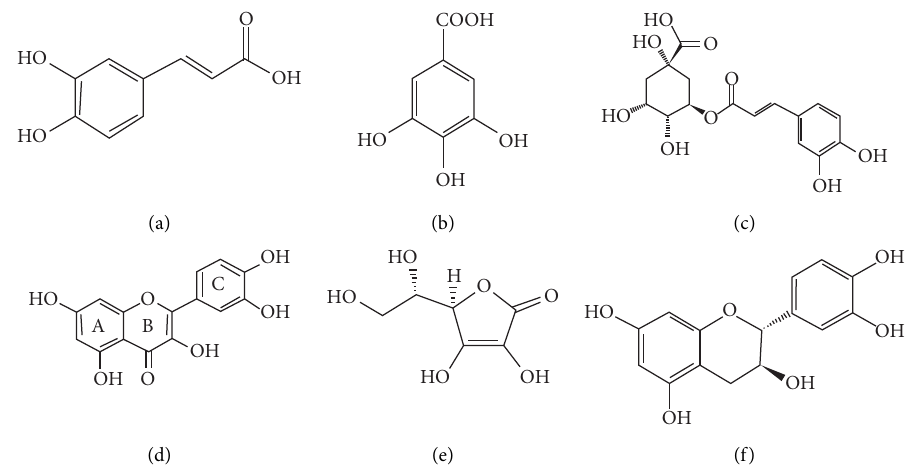
Figure 4: Chemical structures of the main chemical constituents of apricot, black currant, and grape pomace extracts. (a) Caffeic acid. (b) Gallic acid. (c) Chlorogenic acid. (d) Quercetin. (e) Ascorbic acid. (f)